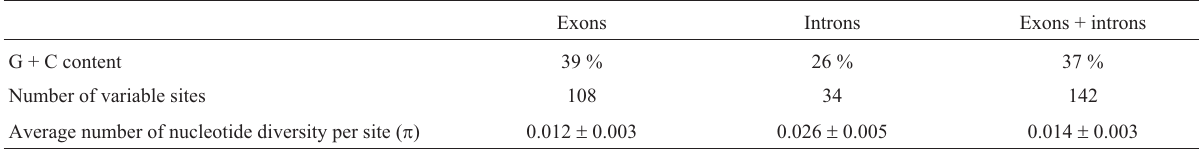
Table 1 - Petunia WOX genes sequence